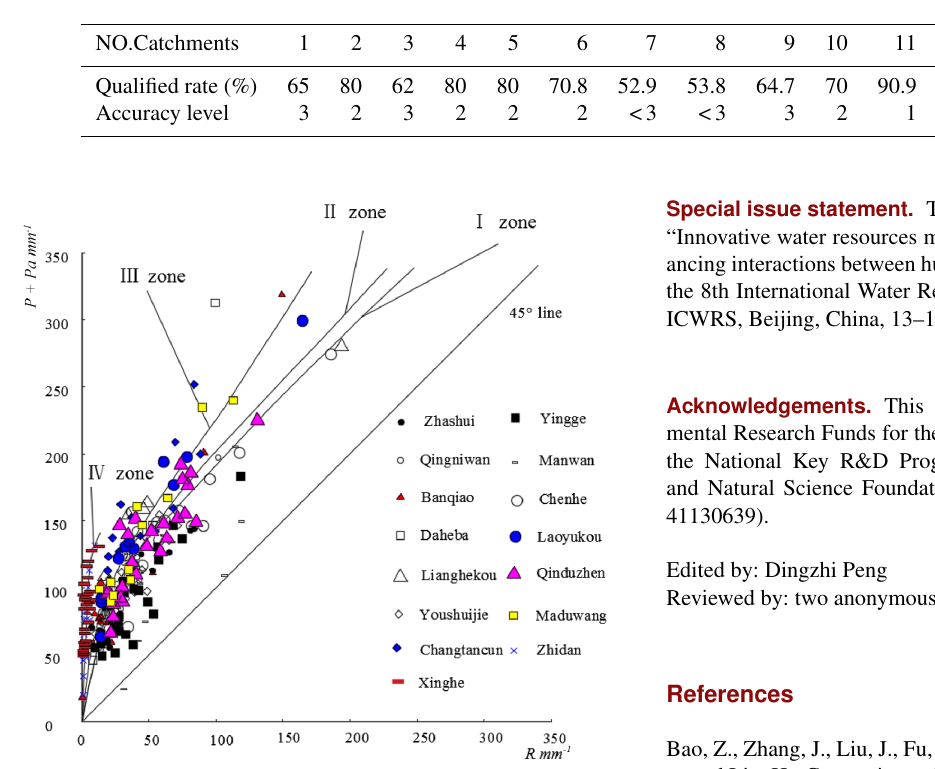
Table 4. The performance of coaxial correlation diagrams.